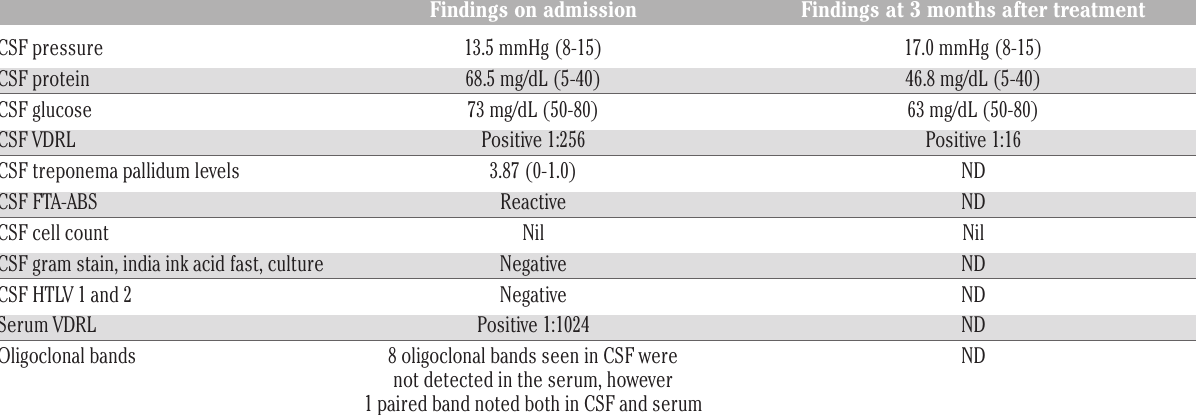
Table 1. Lumbar puncture on presentation and 3 months after treatment. Findings on admission